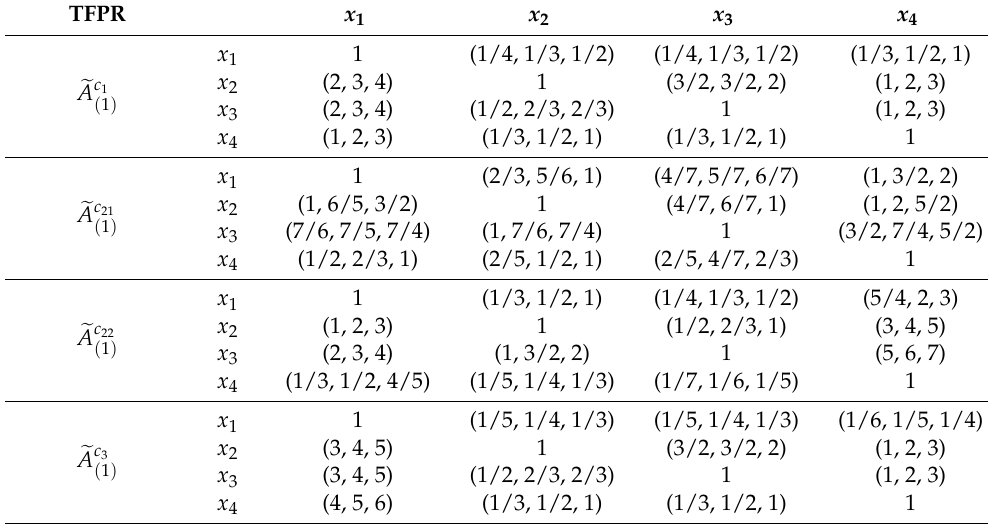
Table 2. Triangular fuzzy judgments provided by the expert e 1